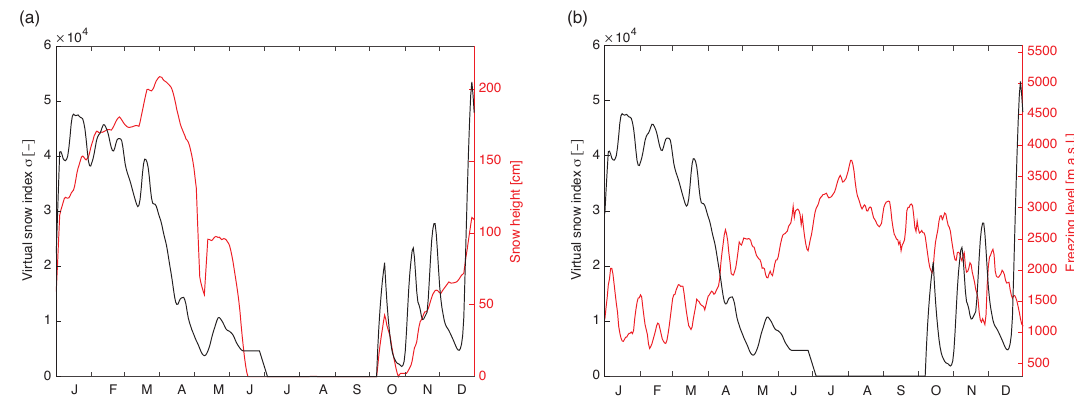
Figure 8. Comparison of the trajectories in 2013 of the Virtual Snow Index σ with the snow height measured at Oga San Colombano (left panel) and with the freezing level (right